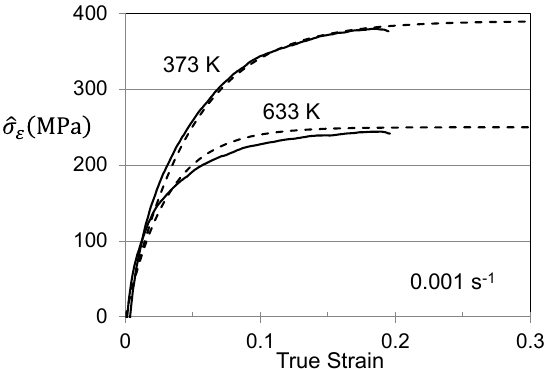
Figure 3. Application of Equation (4) to two measurements in zirconium .